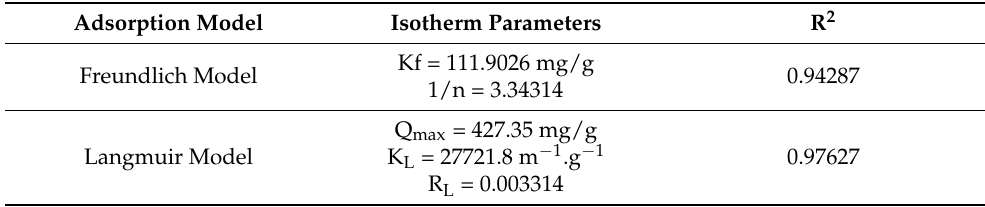
Table 1. Parameters of Langmuir and Freundlich